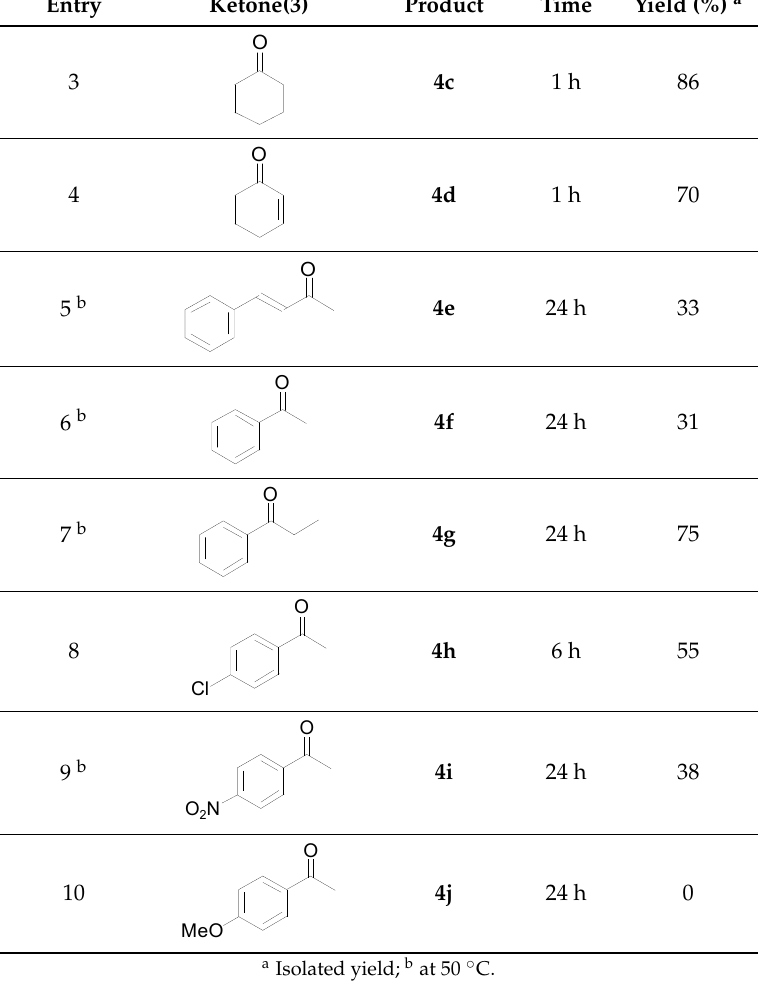
Table 3. TBD catalyzed cyanation of aldehydes with acetyl cyanide .